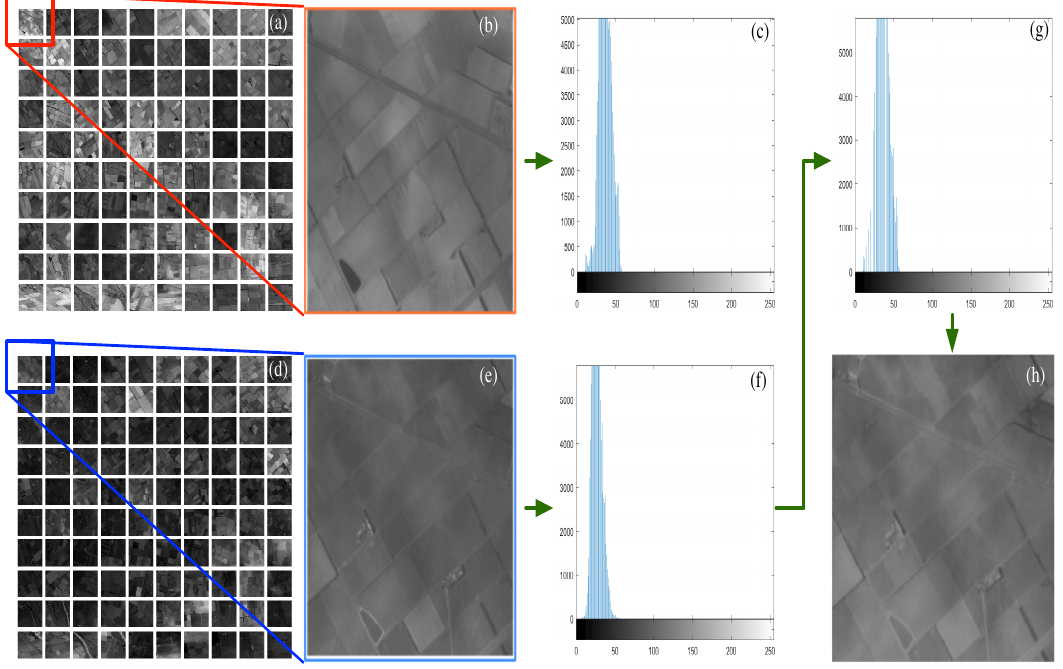
Figure 5. Local histogram matching: ( a ) reference image; ( b ) one image block; ( c ) histogram of ( b ); ( d ) sensed image; ( e ) one image block; ( f ) histogram of ( e ); ( g ) local histogram matching; and ( h ) histogram matched